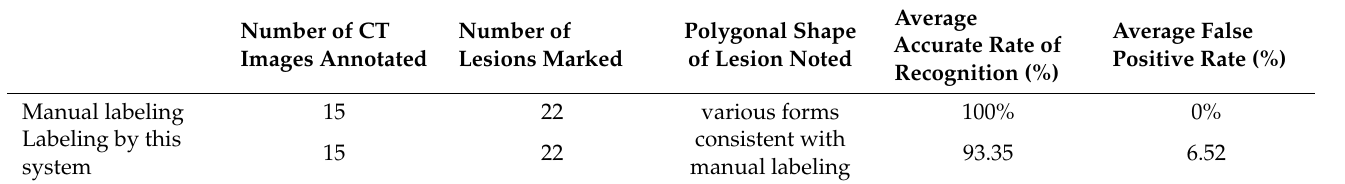
Table 1. Comparison of the labeling results of this system and the manual labeling of